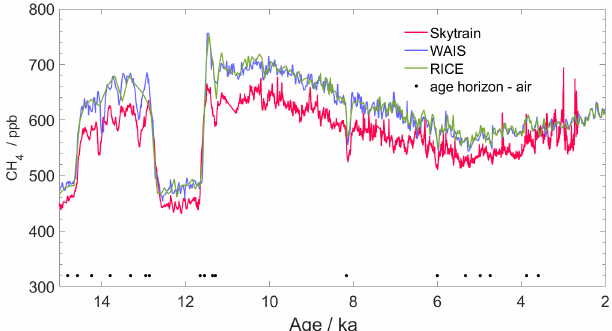
Figure 4. Methane matching over the last 15kyr. Methane from Skytrain Ice Rise (red) on its age scale after synchronisation, along with methane from Roosevelt Island (green) (Lee et al., 2020), and WAIS Divide (blue) (Buizert et al., 2015; Mitchell et al., 2013). Ages shown here are WD2014. The concentration offset between the Skytrain and other data is probably caused by partial dissolution in the melt stream for Skytrain as discussed in the text. Tie points used to construct the age scale are shown as black dots.